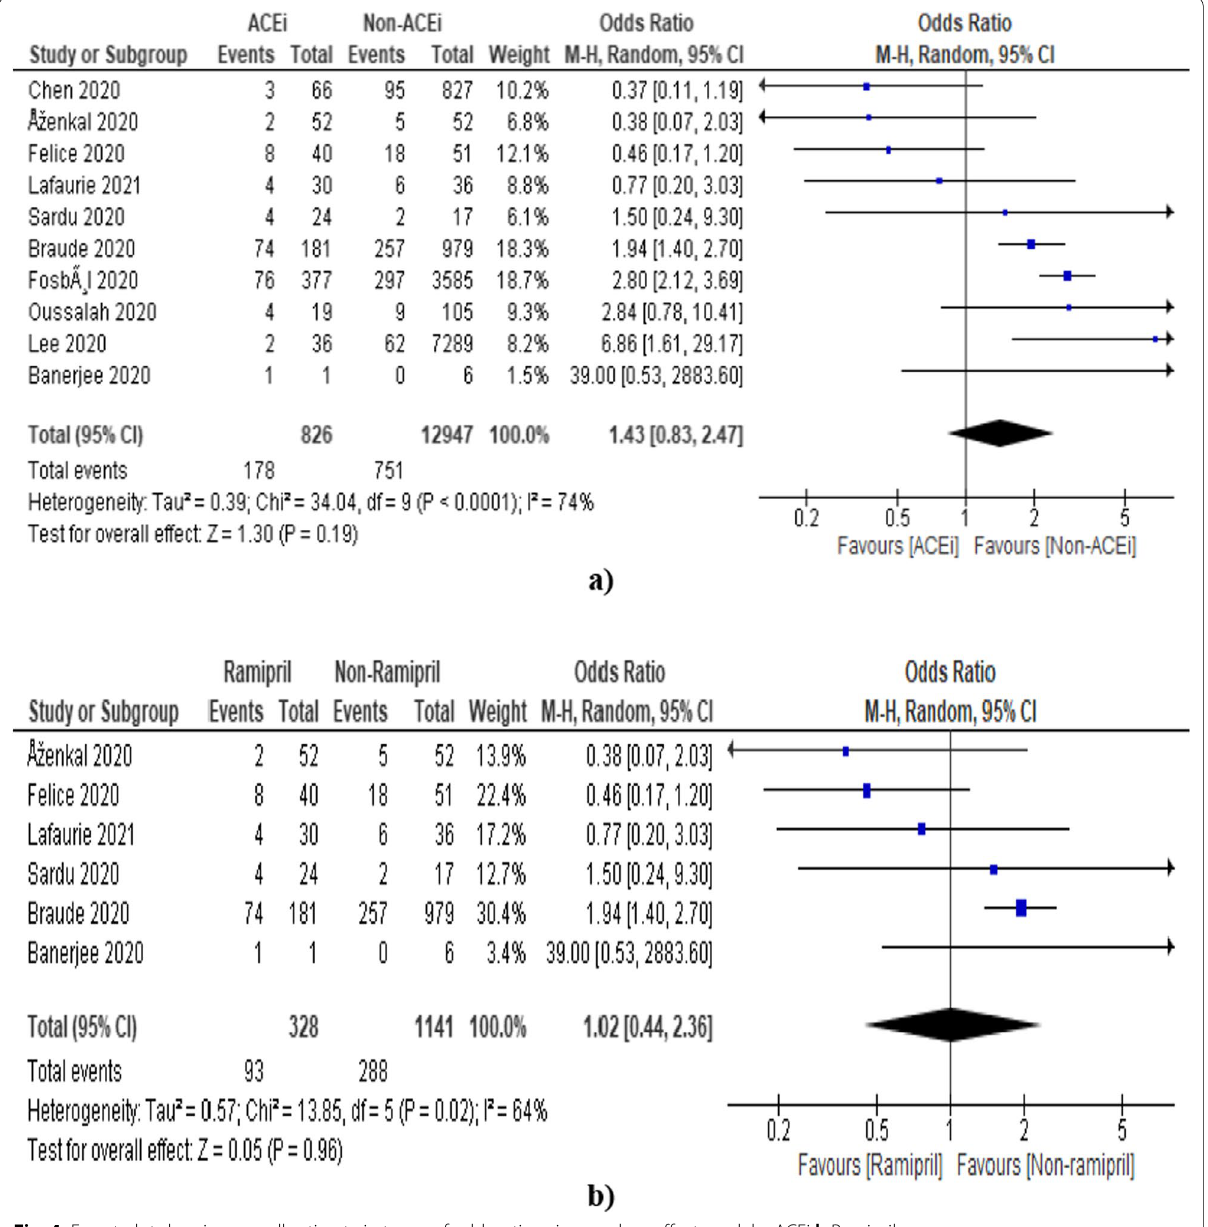
tan only (Additional file 1: Table S6). The pooled odds